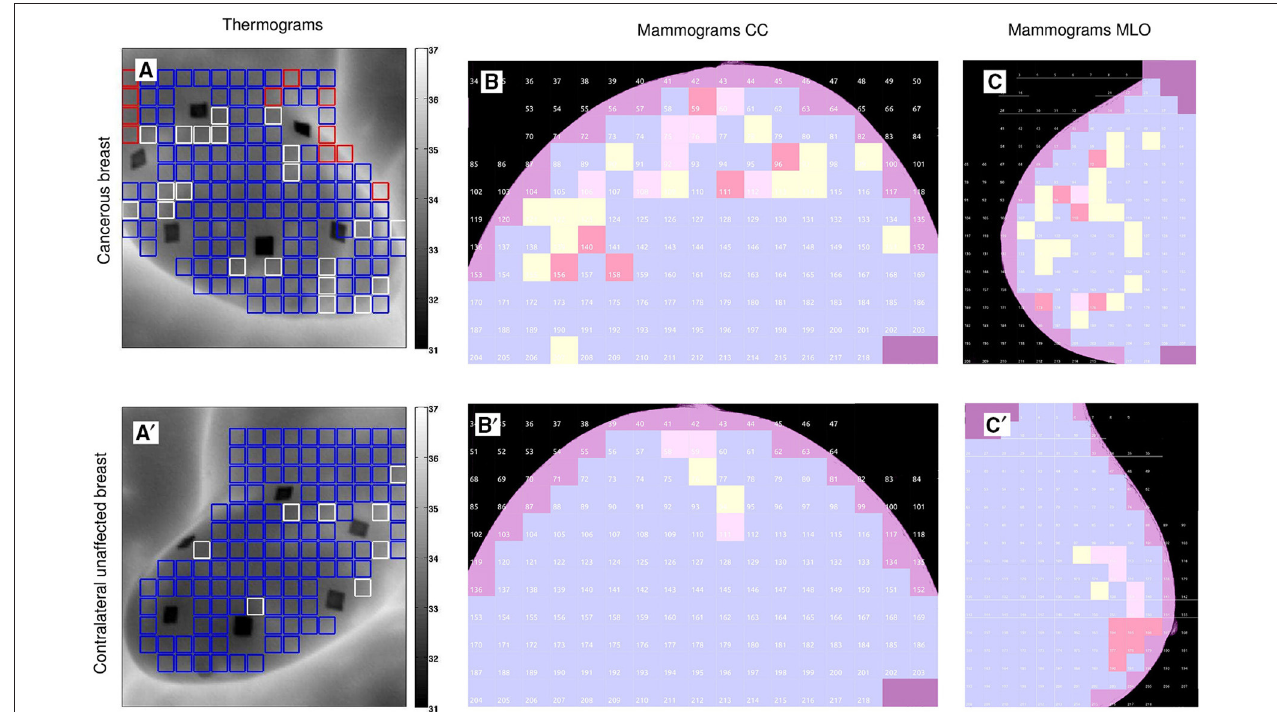
FIGURE 7 | Wavelet-based multifractal segmentation of dynamic infrared thermograms and X-ray mammograms. Same as Figure 1 but for patient 18 (age 37): cancerous left breast (A–C) and contralateral unaffected right breast (A ′ –C ′ ) .